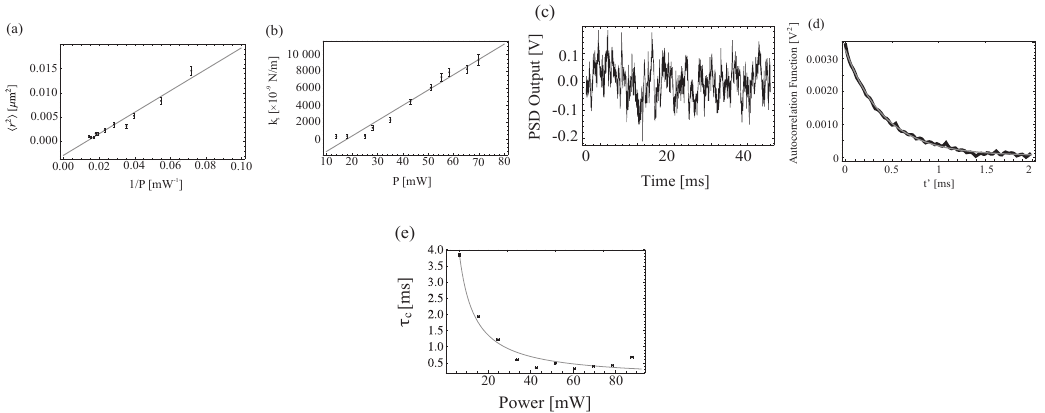
Figure 19. ( a ) Mean squared displacement as a function of inverse laser power. The power represents the measured value at the entrance to the microscope objective. Only ∼ 50% of the light reaches the sample. ( b ) Spring constant of the dipole force trap as a function of laser power. The horizontal axis has not been corrected for the power loss at the microscope objective. The points representing the spring constant are calculated from the data in ( a ) on the basis of the equipartition theorem. ( c ) Signal from the position sensitive detector (PSD), which represents the position of the bead as a function of time. ( d ) Autocorrelation function (black) calculated from the PSD signal by fitting to a Lorentzian (grey) for a small section of the data such as in figure ( c ). The horizontal axis represents the time lag between the data points in the record. The fit gives a correlation time τ c = 0.422 ± 0.005 ms. ( e ) Correlation time as a function of laser